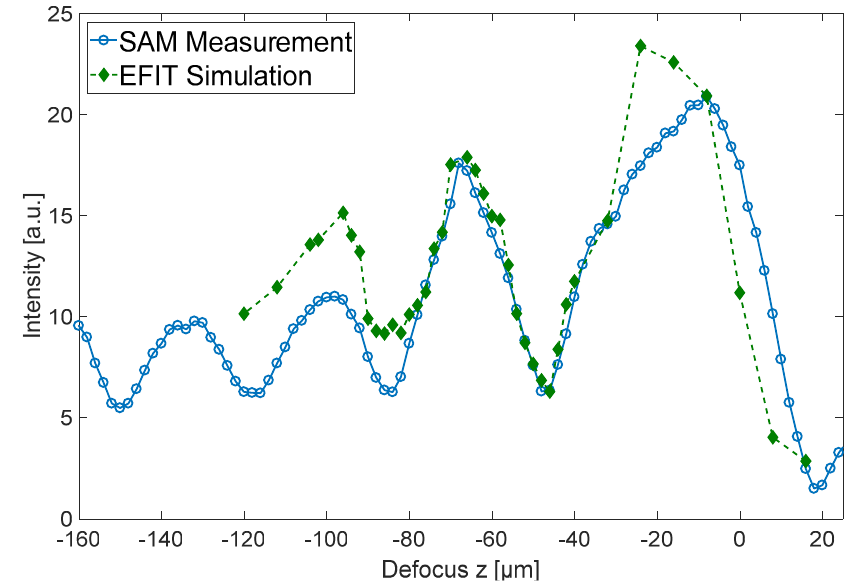
Figure 7. EFIT simulation (diamonds) and SAM measurement (circles) of I ( z ) for an aluminium coating on silicon sample at 400 MHz.